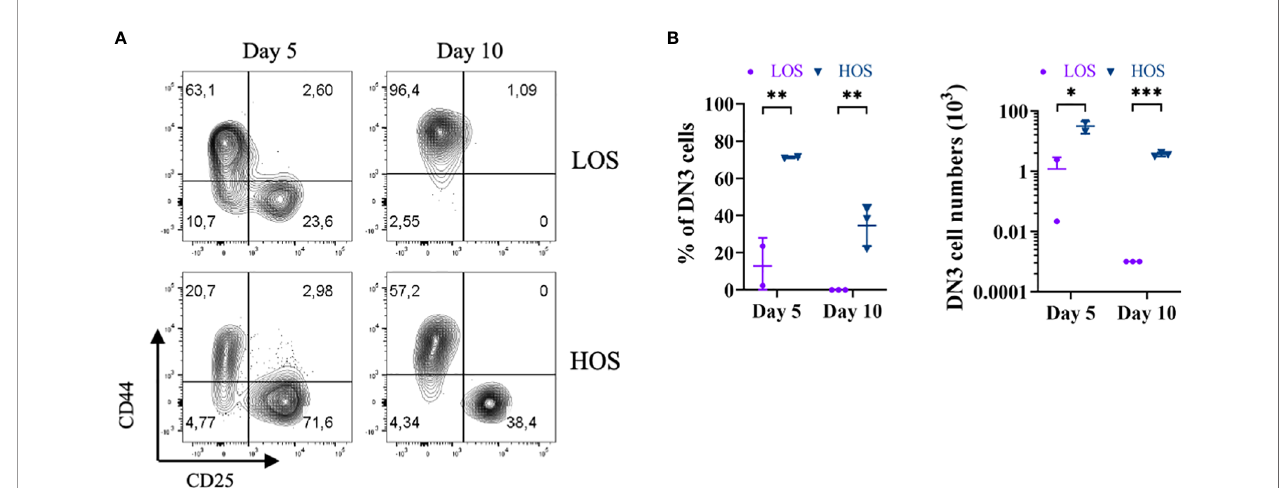
FIGURE 4 | Increased oxygen availability promotes DN3 self-renewal in HOS. (A) Flow cytometric analysis of Rag2 -de fi cient thymocytes from 5- and 10-day LOS and HOS cultures, as indicated. Cells shown were pre-gated as CD45 + CD11b − CD19 − CD4 − CD8 − . (B) Scatter dot plots and statistical analysis (two-way ANOVA with post-hoc Sidak ’ s test) of percentage (%) of DN3 cells (left), and numbers of DN3 cells (right), as indicated. DN3 cells were not detected in LOS cultures on day 10, as such were indicated and analyzed as one cell to enable log-transformation. *p < 0.05; **p < 0.01; ***p <